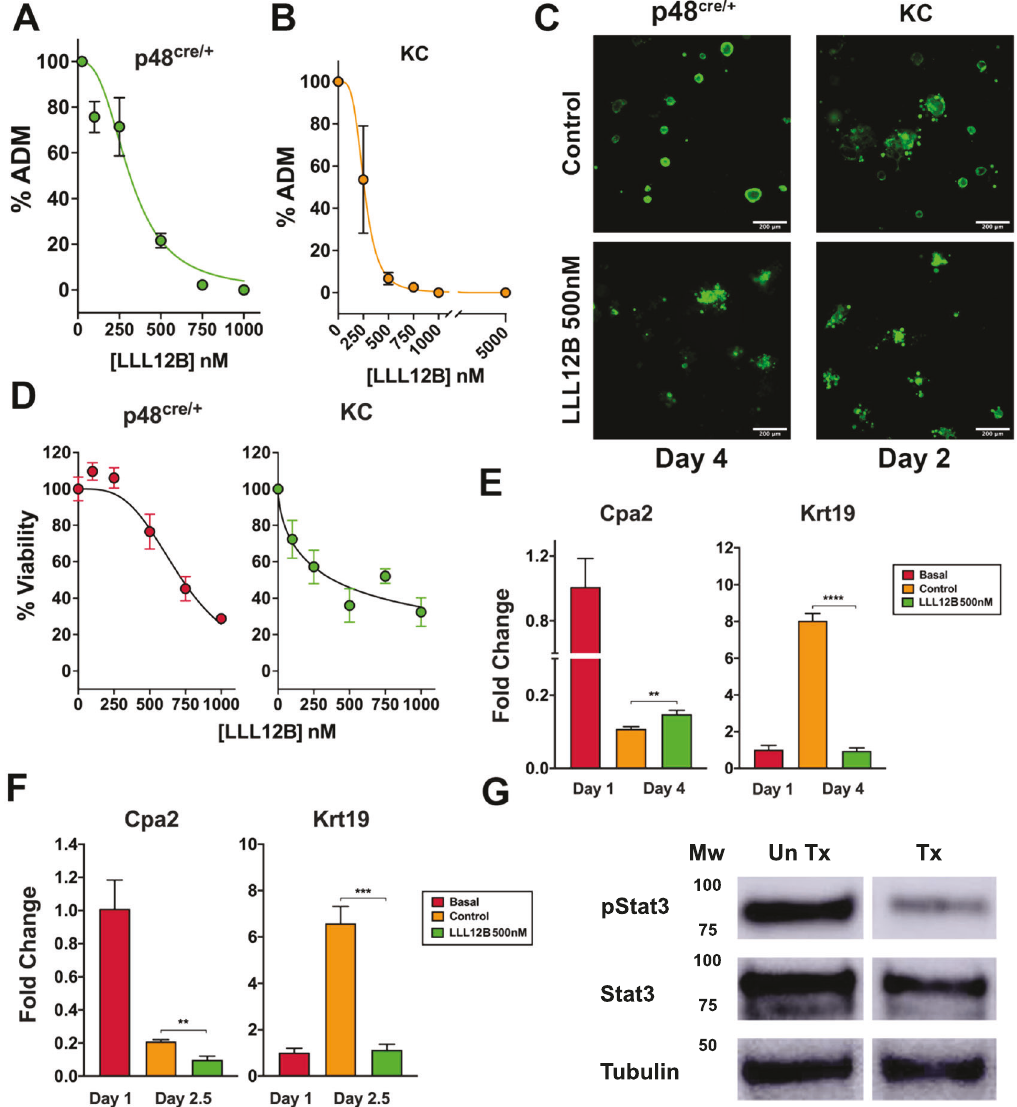
Fig. 1 The pStat3 inhibitor LLL12B attenuates ADM. A p48 Cre/ + mouse acinar cells were treated with LLL12B or untreated control for 4 days and the amount of ADM was microscopically quanti fi ed. B KC mouse pancreatic acini were treated with LLL12B or untreated control for 2.5 days and the amount of ADM was calculated microscopically. The viability of p48 Cre/ + and KC mice treated with 500 nM LLL12B or untreated control for 4 and 2.5 days, respectively, was determined by C calcein AM staining or D MTT assay. The effects of LLL12B on the mRNA expression of Cpa2 and Krt19 in E p48 Cre/ + (4-day exposure of 500 nM) or F KC (2.5-day exposure of 500 nM) mouse organoids as determined by qRT-PCR. The control group represents untreated control while basal represents the untreated day one cultures. G Western blot of KC mouse organoids from untreated (UnTx) or 1000 nM LLL12B treatment (Tx) for 6 h. The phosphorylation site for pStat3 is Tyr705. Mean ± SD from triplicate treatments. ** P < 0.01, *** P < 0.005. **** P <